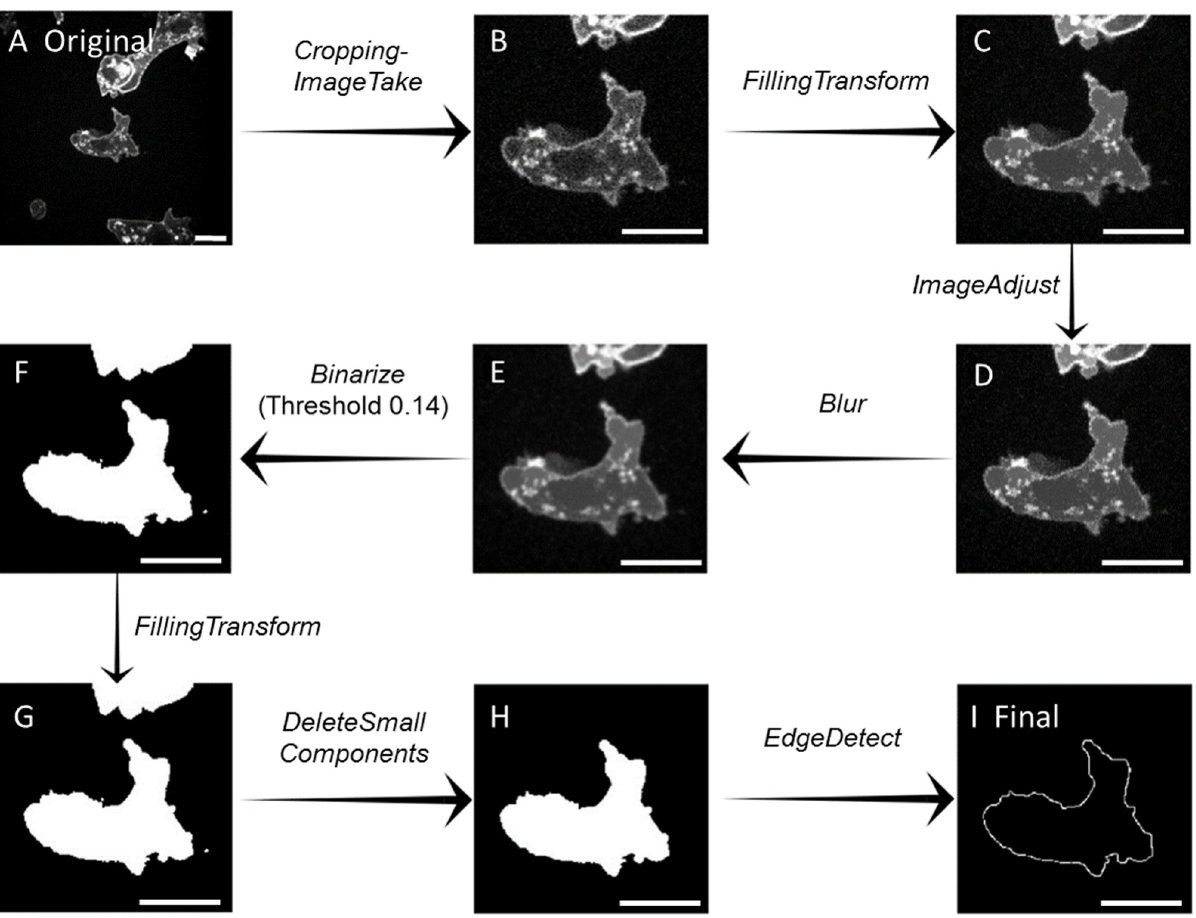
Fig 5. Image processing: Microscopy ! Digitization Flowchart. (A) The original microscopy output. (B) The cropped image. Only unnecessary background was removed. (C) The result of FillingTransform . Very small dark features were blended with adjacent areas to form a more uniformly gray cell interior. (D) ImageAdjust rescaled the brightness component within the unit interval, [0, 1]. (E) The blurring operation modified areas where high intensity and low intensity were adjacent. (F) Binerize reset the image pixels into 0 or 1. The Binerize parameter set the threshold determining which pixels were set to white (1) and black (0). (G) The filling transform was reapplied. (H) DeleteSmallComponents removed any unwanted artifacts, white areas inside the black and black inside the white. This ensured there is only one edge to detect. (I) EdgeDetect identified the edge between the black and white regions. Scale bars identify 10 micron